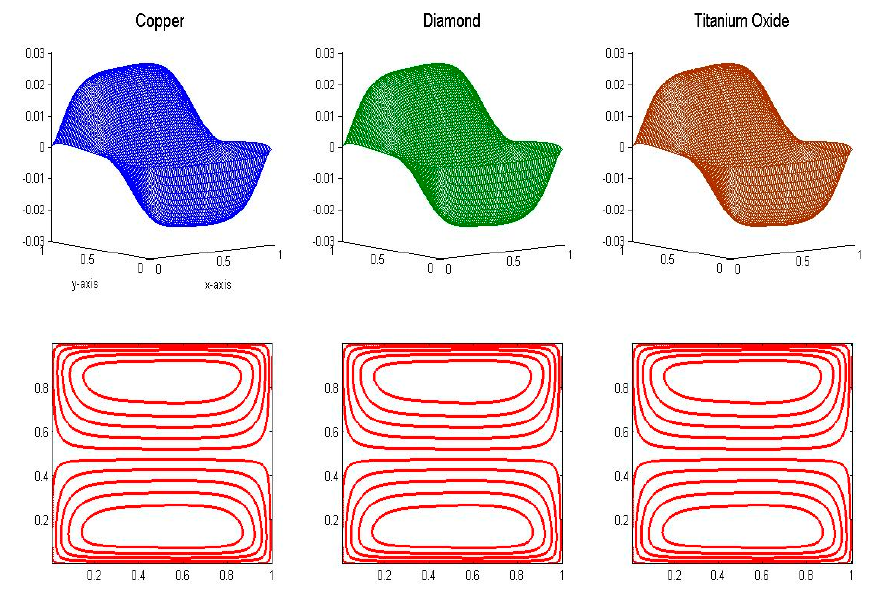
Figure 3. Velocity contours for altered nanoparticles. Table 3. Values of velocity and temperature at x = 0.5.